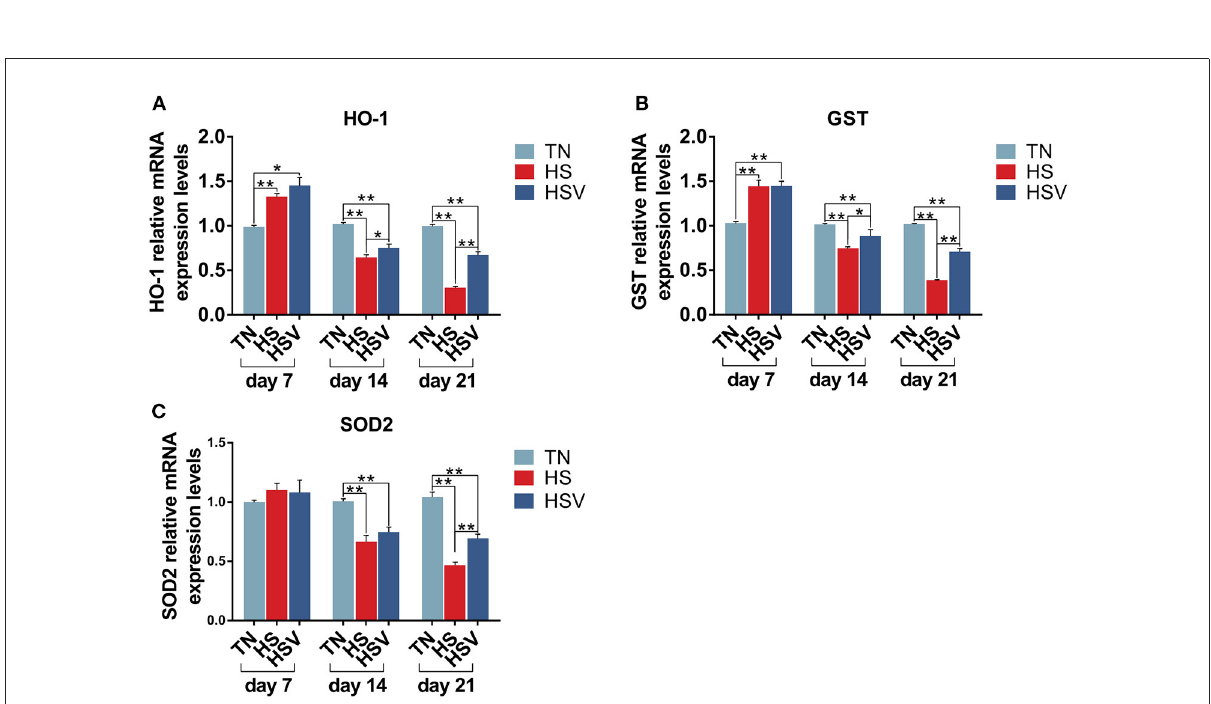
FIGURE4 Effects of vitamin C on chronic heat stress-induced changes in the mRNA expression of oxidative stress genes in the liver. (A) mRNA expression of HO-1; (B) mRNA expression of GST; and (C) mRNA expression of